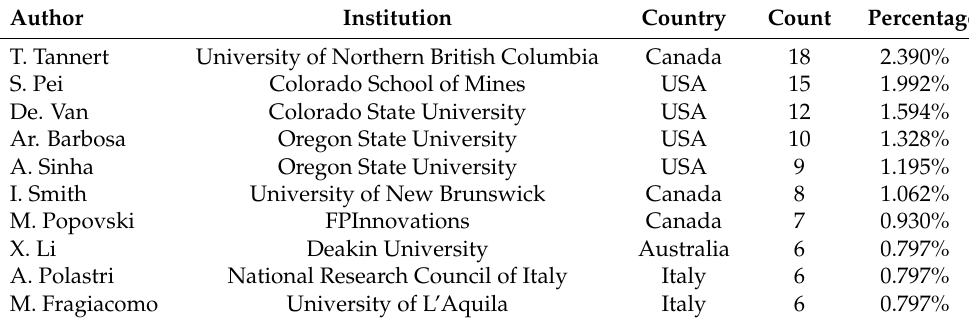
Table 3. List of the top 10 most productive authors in the 2006 – 2022 time period for CLT in con- struction.